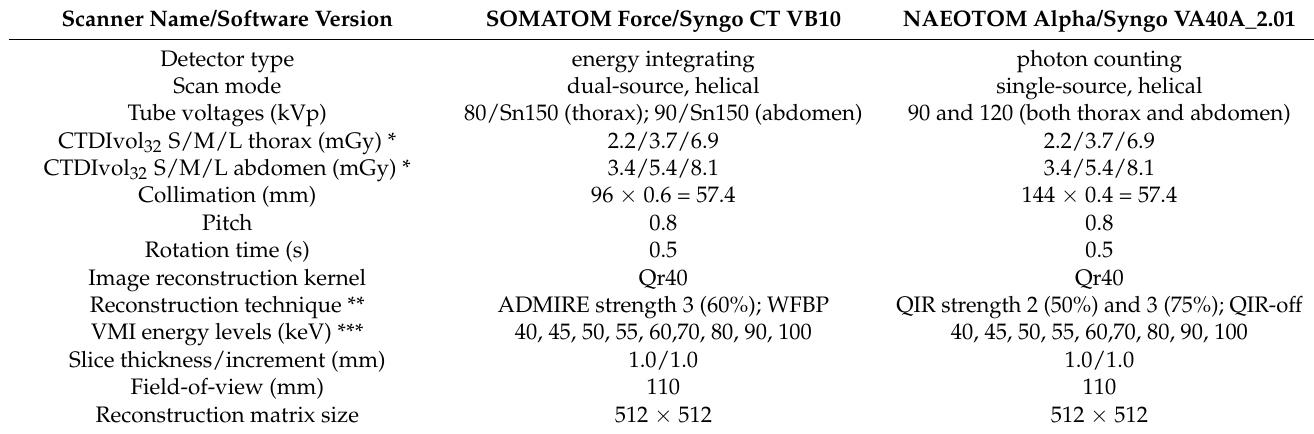
Table 1. Acquisition and reconstruction